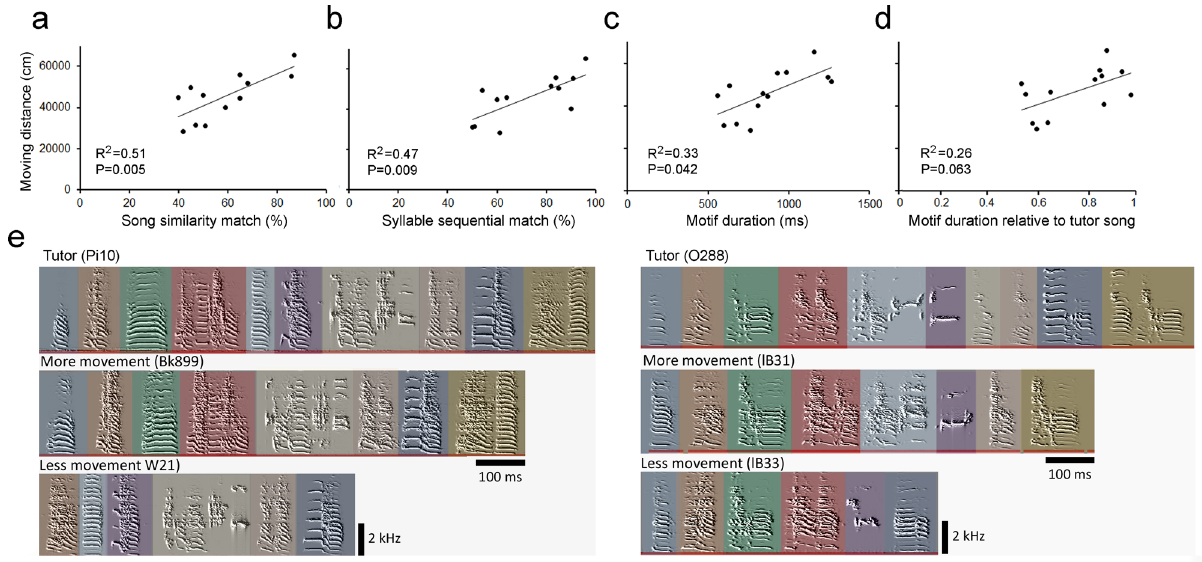
Fig. 3 Individual variation in juvenile locomotor activity was correlated with precision of tutor song imitation. a The average amount of locomotor activity (i.e., mean of total moving distance from 35 to 65 dph, n = 13 birds) of individual juveniles was positively correlated with similarity match of tutor song. b The syllable sequential match (%) of the tutor song was positively correlated with the amount of locomotor activity. c The duration of multisyllable motif was positively correlated with the amount of locomotor activity, and similarly, d however, individual ’ s locomotor movement was not associated with the ratio between the tutee ’ s motif duration and tutor ’ s motif duration, that is, the ratioi between the tutee ’ s motif duration and tutor ’ s motif duration. e Examples show the correlation between juvenile locomotor activity and song learning. The juveniles (Bk899 and lB31) that had more locomotor activity at the juvenile stage also produced a better match of tutor song (60% and 65% respectively) and sequential match (81% and 84%, respectively) than their biologically-related siblings (W21 and lB33; 44% and 45% of tutor song similarity match and 58% and 53% sequential match). Both father tutors (Pi10 and O288) had long motif duration (1448 and 1103 milliseconds respectively). Sonograms depict the crystallized songs recorded from sibling males at around 100 dph, each semi-transparent colored bar represents a